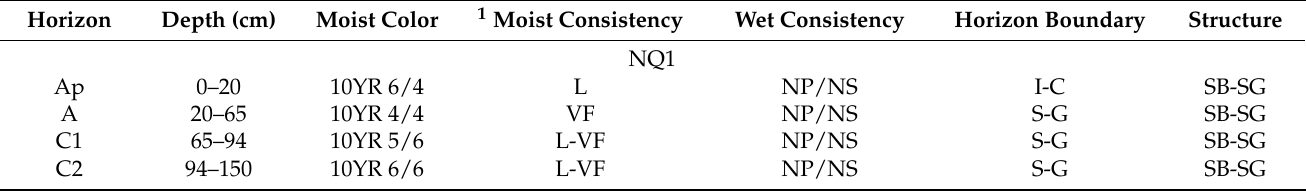
Table 1. Morphological data of the Quartzipsamments profiles of the Southwest of Rio Grande do Sul State, southern